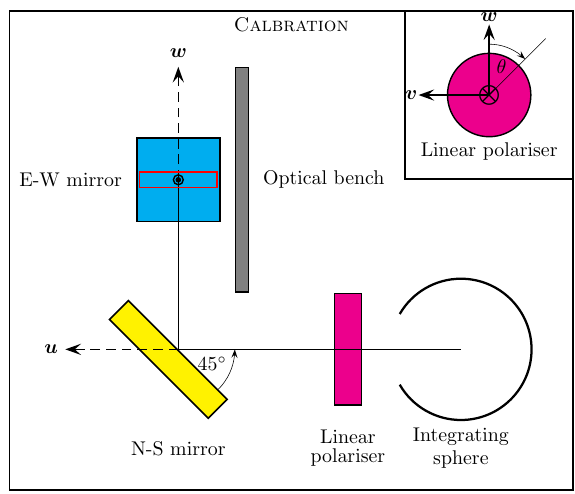
Figure 3. During calibration, both mirrors will be set to their central positions with θ ns = θ ew = π/ 4 , corresponding to nadir observa- tion. Unpolarised light from a calibrated integrating sphere will be passed through a linear polariser along the optic axis to the north– south scan mirror. The polariser will be rotated about the u axis so that the plane of polarisation makes an angle θ with the u – w plane, as shown in the upper-right insert. When θ = 0, the plane of polar- isation (after reflections) is parallel to the slit; when θ = π/ 2, the plane of polarisation is perpendicular to the slit. The output poten- tial v(θ) from the detector will be monitored as a function of θ